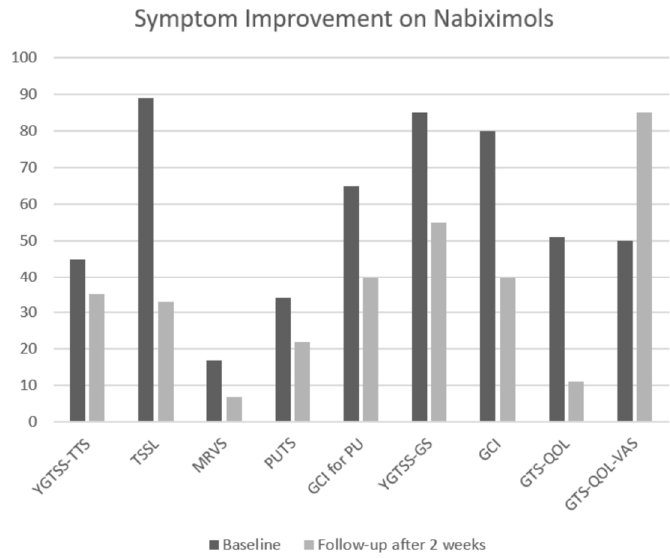
Figure 1. Symptom improvement with nabiximols. For GTS-QOL-VAS a lower score represents better quality of life; for all other scales a higher score is better. Abbreviations: YGTSS-TTS = total tic score of the Yale Global Tic Severity Scale (range: 0–50), TSSL = Tourette Syndrome Symptom List (range: 0–336), MRVS = Modified Rush Video-Based Tic Scale (range: 0–20), PUTS = Premonitory Urge for Tics Scale (range: 0–36), GCI for PU = Global Clinical Impairment for premonitory urges (range: 0–100), YGTSS-GS = Global scale of the Yale Global Tic Severity Scale (range: 0–100), GCI = Global Clinical Impairment (range: 0–100), GTS-QOL = Gilles de la Tourette Syndrome-Quality of Life Scale (range: 0–100), GTS-QoL-VAS = Visual Analogue Scale for satisfaction of the GTS-QOL (range: 0–100).